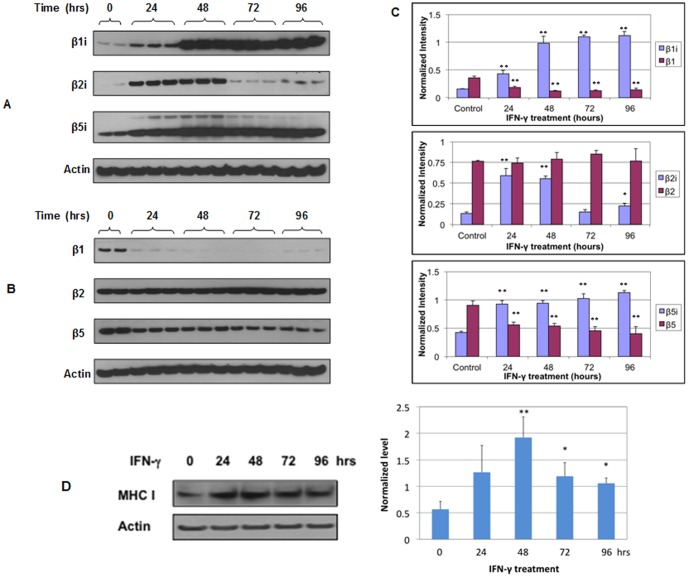
IFN-γ induces the expression of immunoproteasome β subunits in HSG cells.The cells were treated with IFN-γ at 250 U/ml for 24, 48, 72 or 96 hours. Western blotting was used to determine the levels of β1i, β2i and β5i (A) and proteasome β subunits β1, β2 and β5 (B) in IFN-γ-treated cells (n = 3 at each time point) and untreated cells (control, n = 2). (C) Normalized levels of immunoproteasome β subunits in relation to constitutive proteasome β subunits in IFN-γ-treated and untreated HSG cells. For each time point, three biological replicates (three cell lysates samples obtained from three separate wells of the 6-well plate) were used for Western blot analysis and the error bars represent the standard deviations at each time point. Computation of p values was done at each time point versus the control (untreated cells). *, p<0.05; **, p<0.01. (D) Western blot analysis of MHC class I in untreated and IFN-γ-treated HSG cells (250 U/ml for 24–96 hrs). *, p<0.05; **, p<0.01. Similarly, three biological replicates at each experimental condition were used for the analysis.